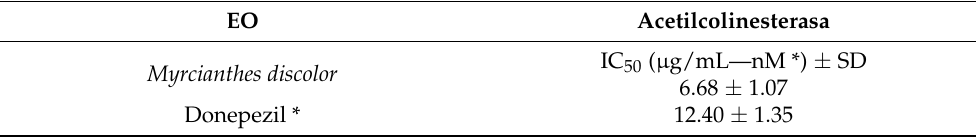
Figure 2. Inhibitory effect plot of the Myrcianthes discolor EO, against acetylcholinesterase. Table 5. Anticholinesterase activity of the essential oil of Myrcianthes discolor